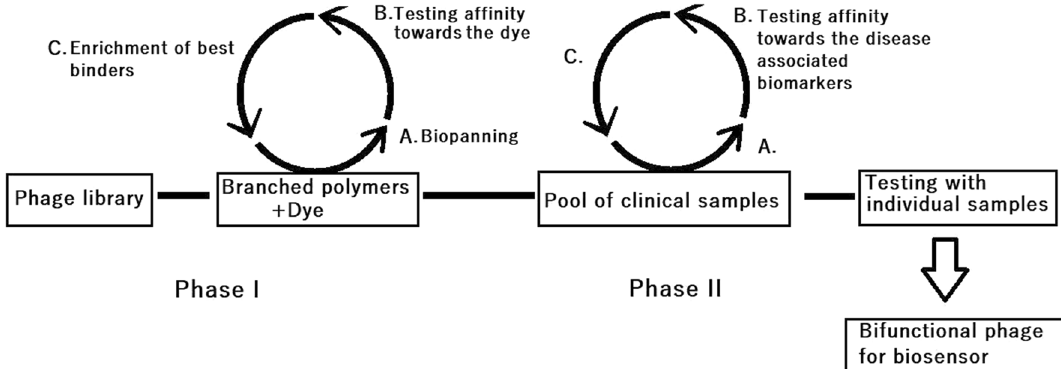
Figure 1. Schematic diagram of two-phase biopanning process and creating interaction between the phage, dye and the biomarkers of interest, such as ones in lethal PCa urine